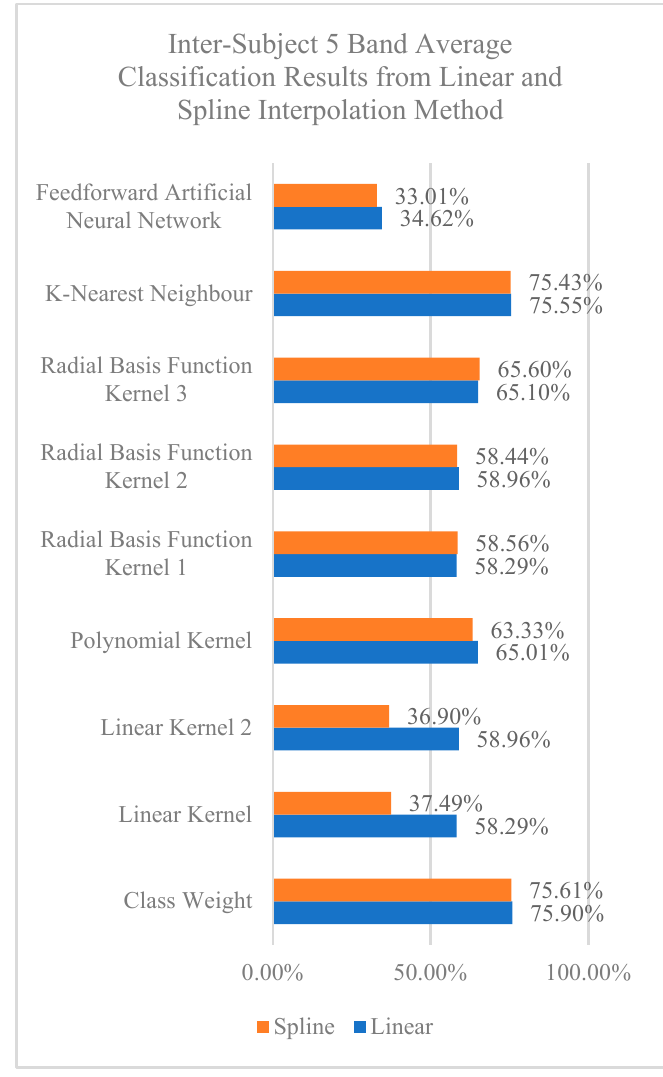
Figure 6. Inter-subject classification results using five bands. To further improve the classification accuracy, the default parameters of the classifiers were then tuned in the next set of experiments. The dataset used for this classification results was based on the linear interpolation method as it consistently produced better classification accuracies over the spline interpolation method when adopting the inter- subject variability approach presented earlier above. The results for the tuned classifiers are shown in Figure 7. By tuning the parameters of the classifiers, it was observed that the majority of the classifiers showed improvements throughout. Noticeably, the most improvements were gained by the radial basis function kernel 1 and radial basis function kernel 3, followed by class weight kernel, all of which were from the SVM classifier. Through ranking, it can be seen that radial basis function kernel 1 achieved the highest accuracy at 85.01%, followed closely by class weight kernel at 84.80%, the radial basis function kernel 3 at 84.44%, and finally KNN at